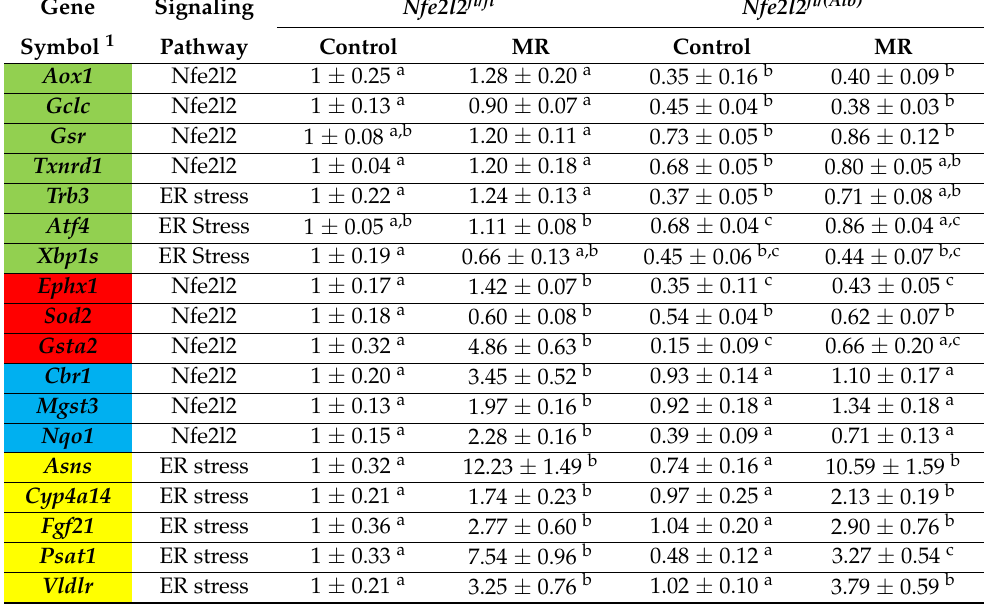
Table 1. Genetic markers of NRF2 transcriptional program and ER stress response in livers